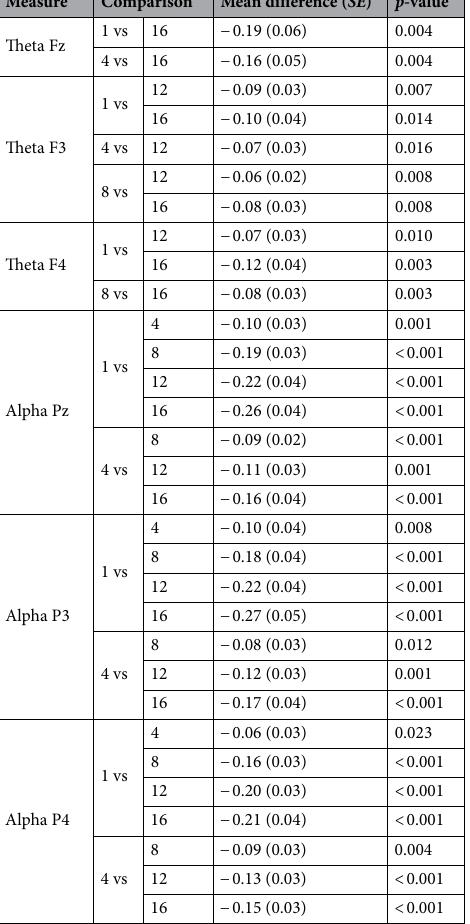
Table 3. Paired t-tests for EEG Theta and Alpha activity, significant comparisons only (one-tailed). Alpha levels are Bonferroni-Holm